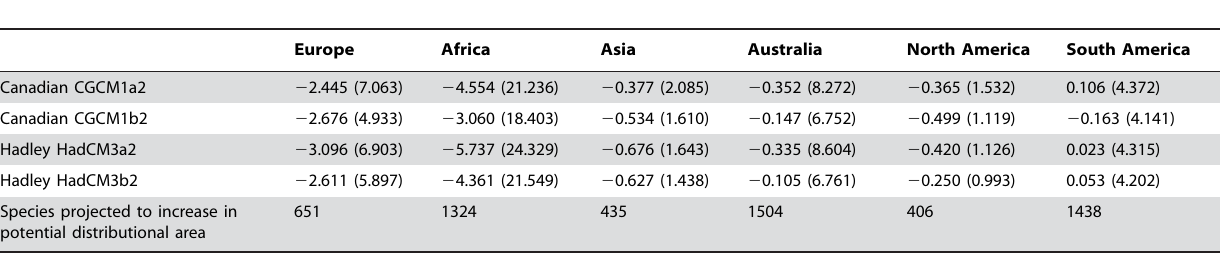
Table 2. Summary of projected climate change effects on native ranges of European plants, as well as on modeled potential invasive ranges on other continents, as a function of 4 different models and scenarios of future (2055) climates.